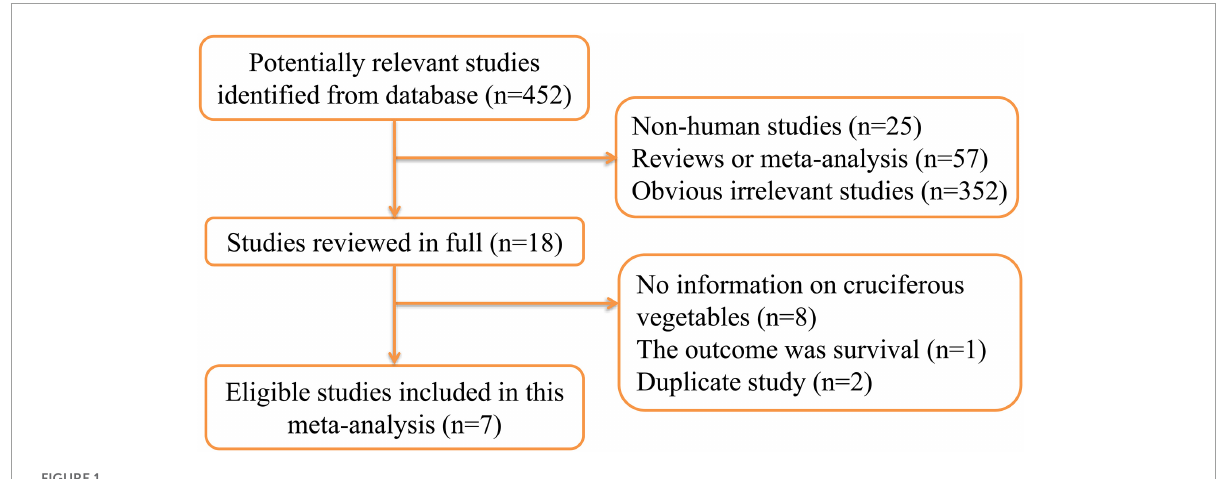
FIGURE1 Flow diagram of literature search and study